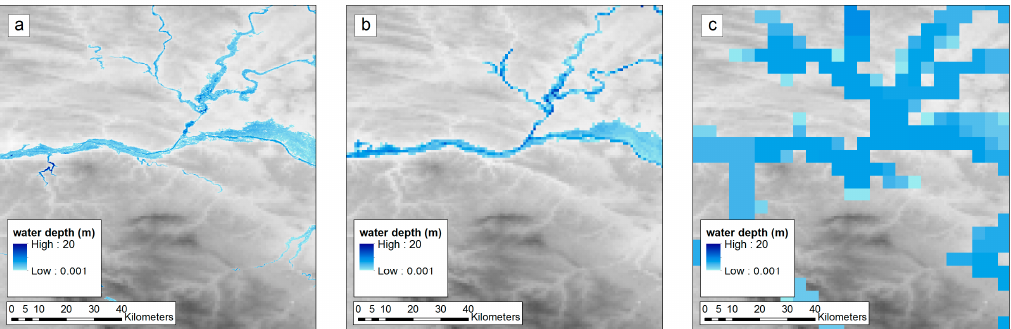
Figure 1. Inundation maps for a 1-in-100-year flood event from the three cases for Central France, with resolution between parentheses. ( a ) JRC Europe (JRC-EU) (100 m); ( b ) JRC Global (JRC-GL) (~1 km); ( c ) Inter-Sectorial Impacts Model Intercomparison Project (ISIMIP) (~5 km). Note that for each flooded cell of the ISIMIP grid, the fraction of area inundated is also given.